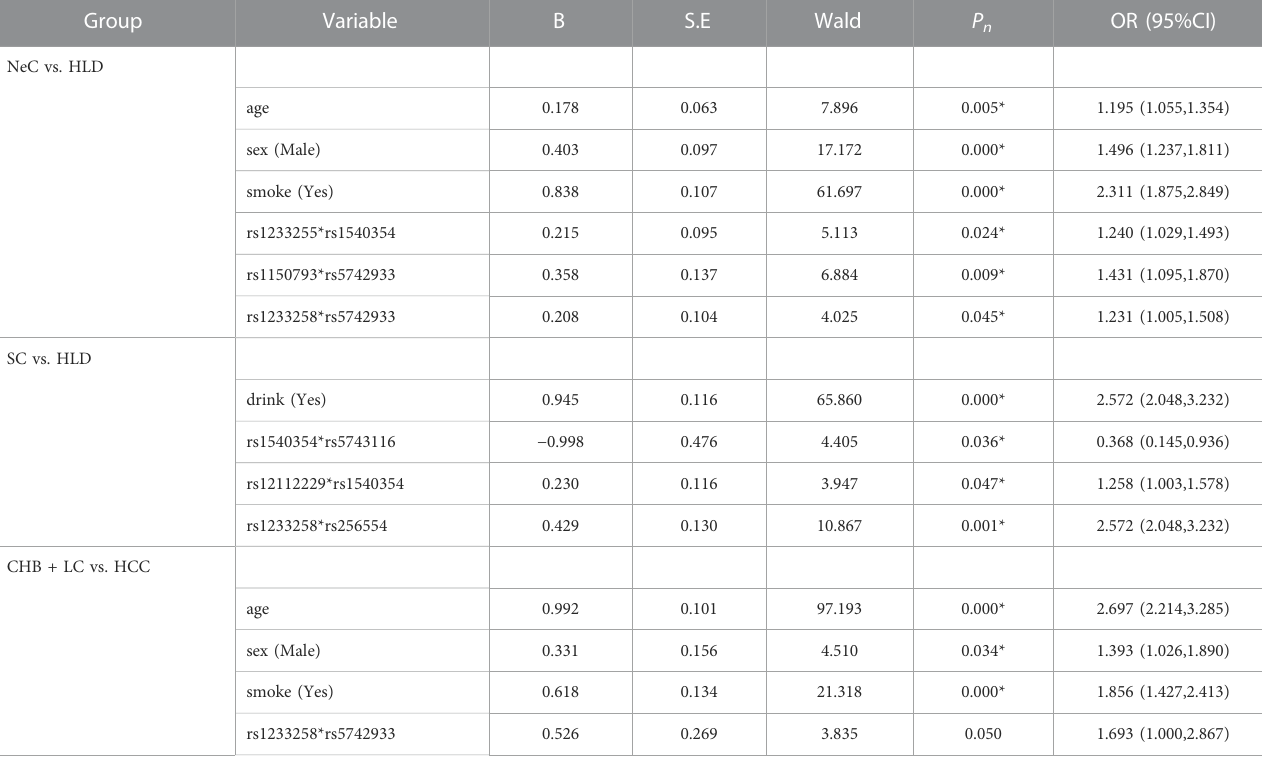
TABLE 4 The multiplicative interaction analysis of predictive factors in NeC vs. HLD, SC vs. HLD and CHB + LC vs. HCC groups by Logistic Regression model. Group Variable B S.E NeC vs. HLD